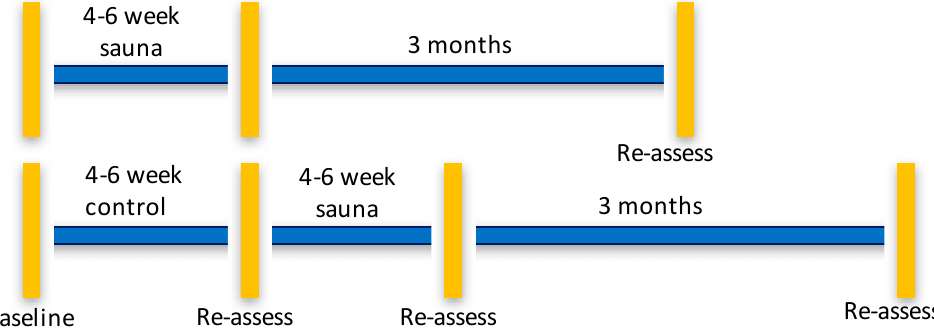
Figure 1. Timeline of assessment points for sauna intervention and waitlist control groups. Vertical bars indicate assessments of all outcomes were performed. Horizontal lines indicate the time frame of the study and follow-ups.